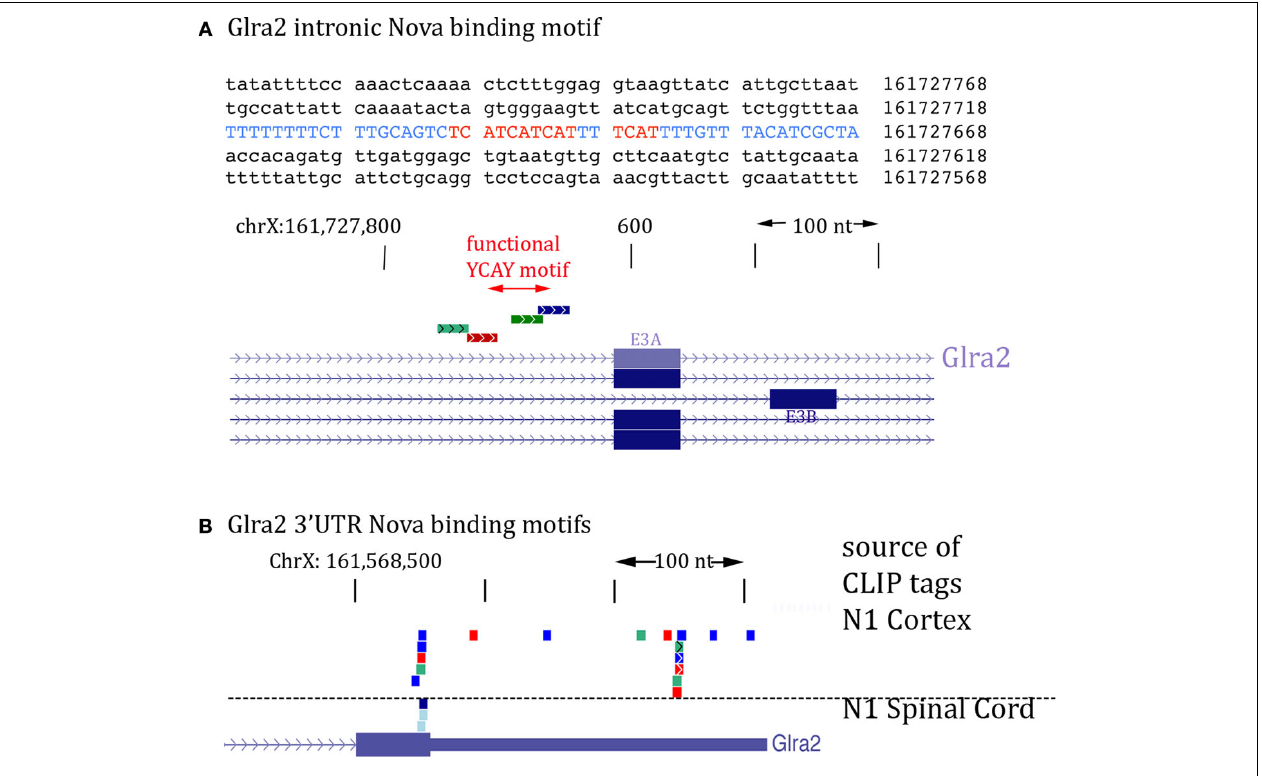
abrogates E3A splicing (Buckanovich and Darnell, 1997). Lower panel shows Nova HITS-CLIP tags in this intronic region. (B) Nova HITS-CLIP tags in the GlyR α 2 3 ′ UTR. In (A,B) Nova tags are colored as in Figure 6